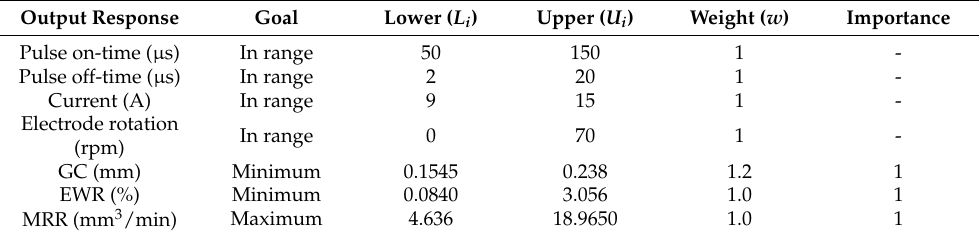
Figure 10. GC mf as a function of ( a ) pulse on-time and pulse off-time, given current = 12 A and electrode rotation = 35 rpm, ( b ) pulse on-time and current, given pulse off-time = 10 µs and electrode rotation = 35 rpm, ( c ) pulse on-time and electrode rotation, given pulse off-time = 10 µs and current = 12 A. Table 9. Criteria for multi-response optimization of EDM with side